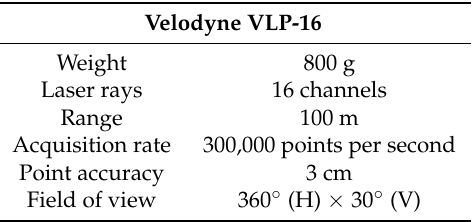
Table 1. Technical characteristics of Velodyne VLP-16 provided by the